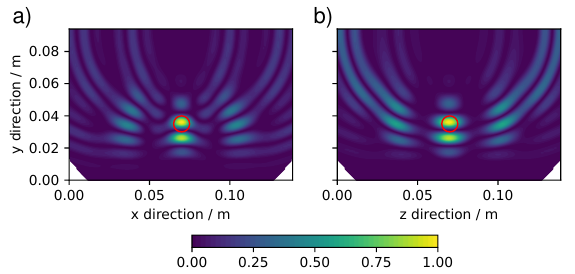
Figure 5. Confocal map for a 6 cm deep target at 0.6 GHz with a 3 × 3 antenna grid. ( a ) x-parallel slice and ( b ) z-parallel slice. Expected target position is indicated by a red